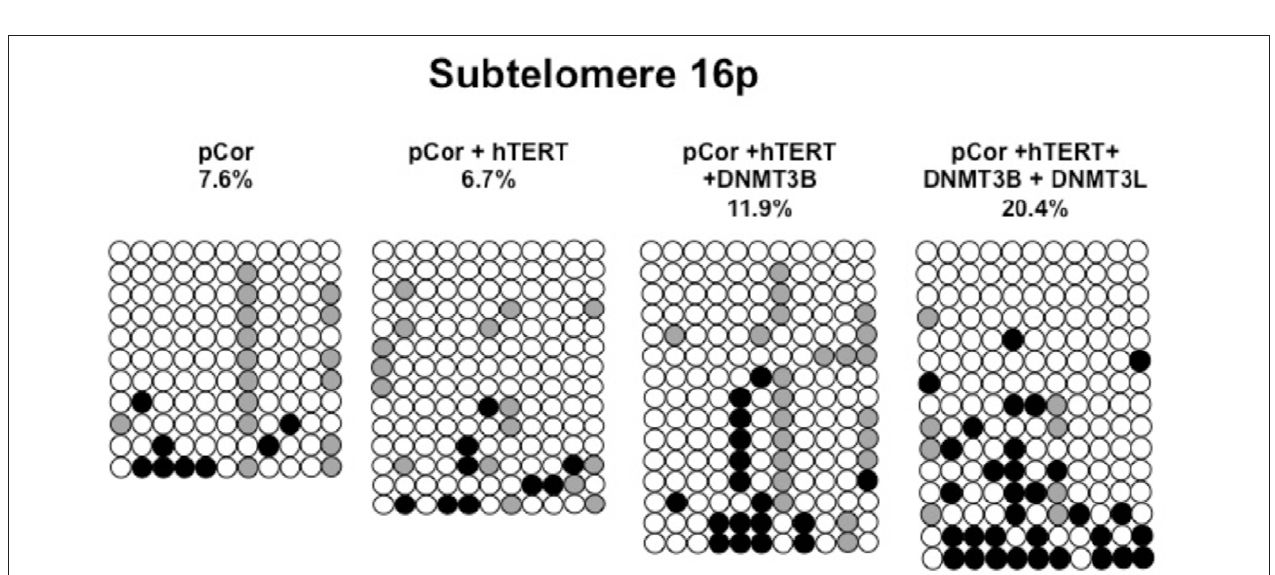
FIGURE A8 | Bisulfite analysis of subtelomeric region 16p. Bisulfite sequence analysis was carried out for a region in subtelomere 16p in pCor, pCor + hTERT, pCor + hTERT + DNMT3B1 and pCor + hTERT + DNMT3B1 + DNMT3L fibroblasts. The analyzed region contains 11 CpG sites. White circles represent unmethylated CpG